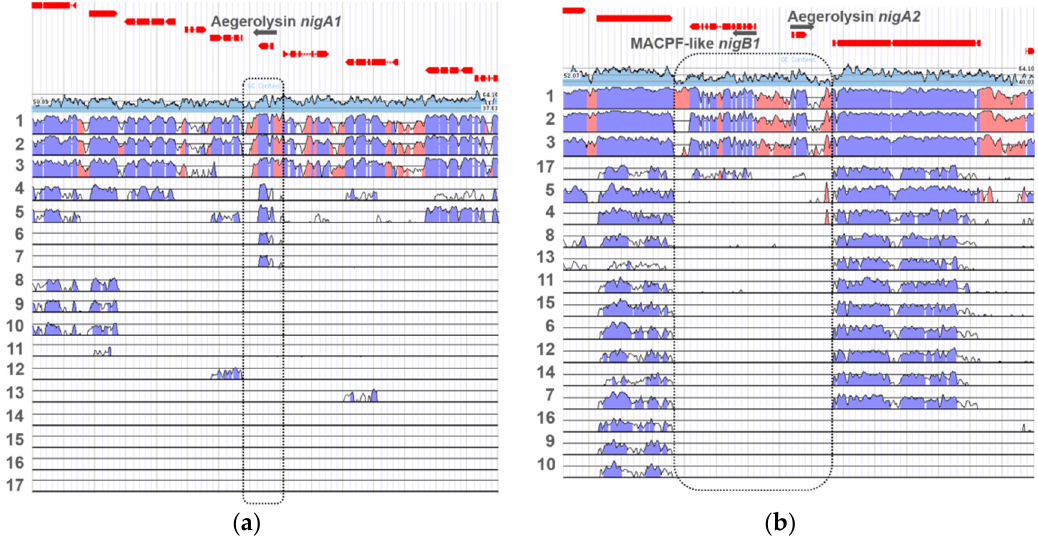
Figure 6. Loci of aegerolysin genes in Aspergillus niger CBS 513.88. Nucleotide conservation for the aegerolysin nigA1 (supercontig 19:43975-59064) ( a ), and nigA2 gene loci (supercontig 01:2367156-2382065) ( b ). Loci were compared to genomes of A. luchuensis (1), A. tubingensis (2), A. brasilliensis (3), A. aculeatus (4), A. carbonarius (5), A. oryzae (6), A. flavus (7), A. wentii (8), A. sydowii (9), A. versicolor (10), A. clavatus (11), A. glaucus (12), A. zonatus (13), A. fischeri (14), A. terreus (15), A. nidulans (16), and A. fumigatus (17). Light blue, GC content; regions of high conservation: dark blue, exons; pink, non-coding. The dotted line indicates (expected) position of aegerolysin loci. Data were collected from JGI MycoCosm [23].